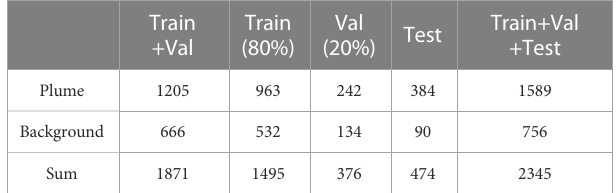
TABLE 1 Numbers of images of different subsets in the deep-sea hydrothermal plume